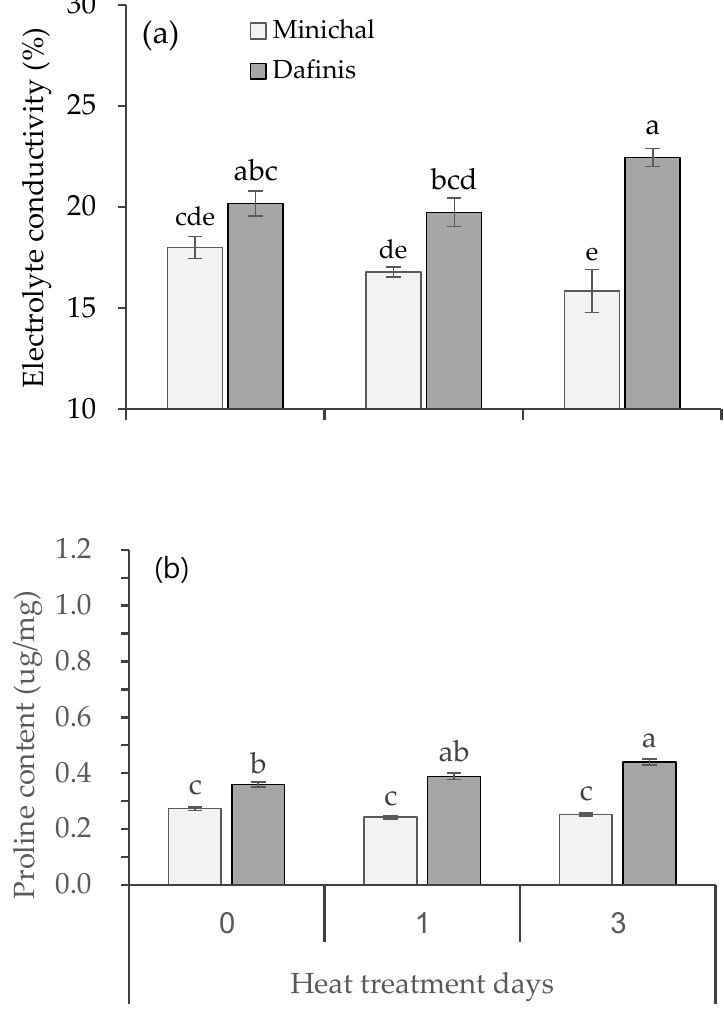
Figure 5. Electrolyte conductivity ( a ) and proline content ( b ) as affected by different heat treatment days in tomato seedlings of Minichal and Dafnis grown at 40 ◦ C. Vertical bars represent ± SE (n = 3). Means with different letters indicate significant differences at p ≤